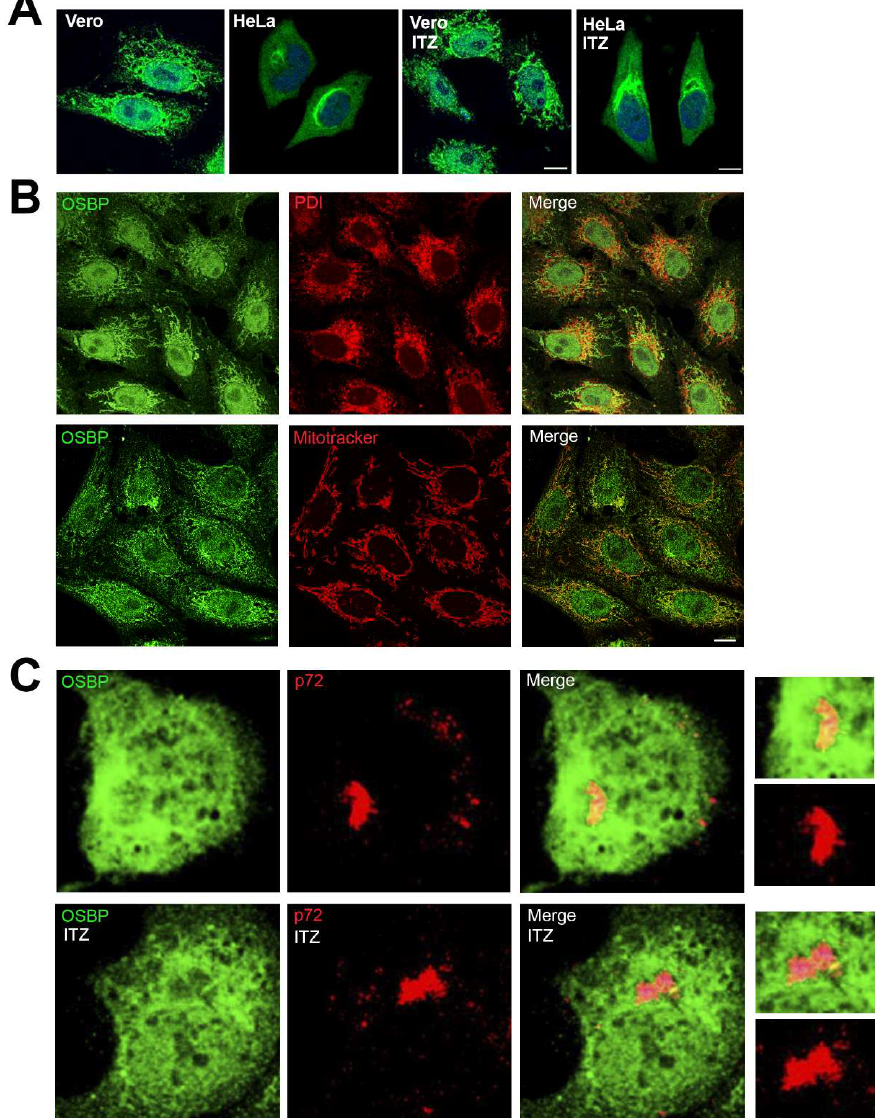
Figure 5. Redistribution of OSBP in ASFV infected cells independently of ITZ. ( A ) OSBP distribution in HeLa and Vero cells treated with 25 µ M ITZ or DMSO for 16 h, fixed and stained with antibody against OSBP (green). DNA was stained with Topro3 (blue). Bar 10 µ m. ( B ) Vero cells were stained with antibody against OSBP (green) and PDI or Mitotracker (red). Bar 10 µ m. ( C ) Vero cells were treated with ITZ or DMSO, infected with ASFV for 16 h and immunostained for viral capsid protein p72 (red) and OSBP (green). Merged image depicts colocalization in yellow at the external boundaries of the VFs. Detail in the zoom images. Bar 25 μm.